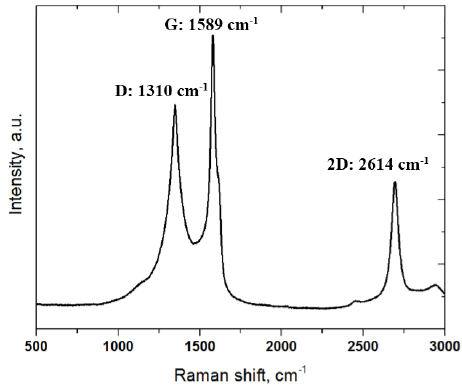
Figure 4. Raman spectrum taken from the C/C-SiC composite.